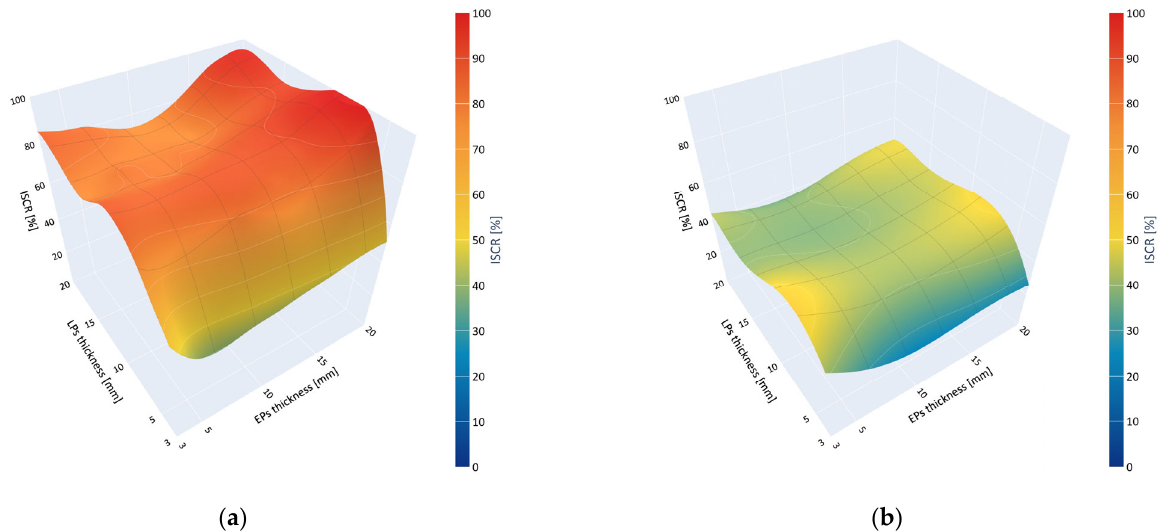
Figure 7. Response surfaces of the maximal ISCR in relation to the thickness of EPs and LPs for ( a ) Concept Z with cell A and ( b ) Concept Z with cell B.